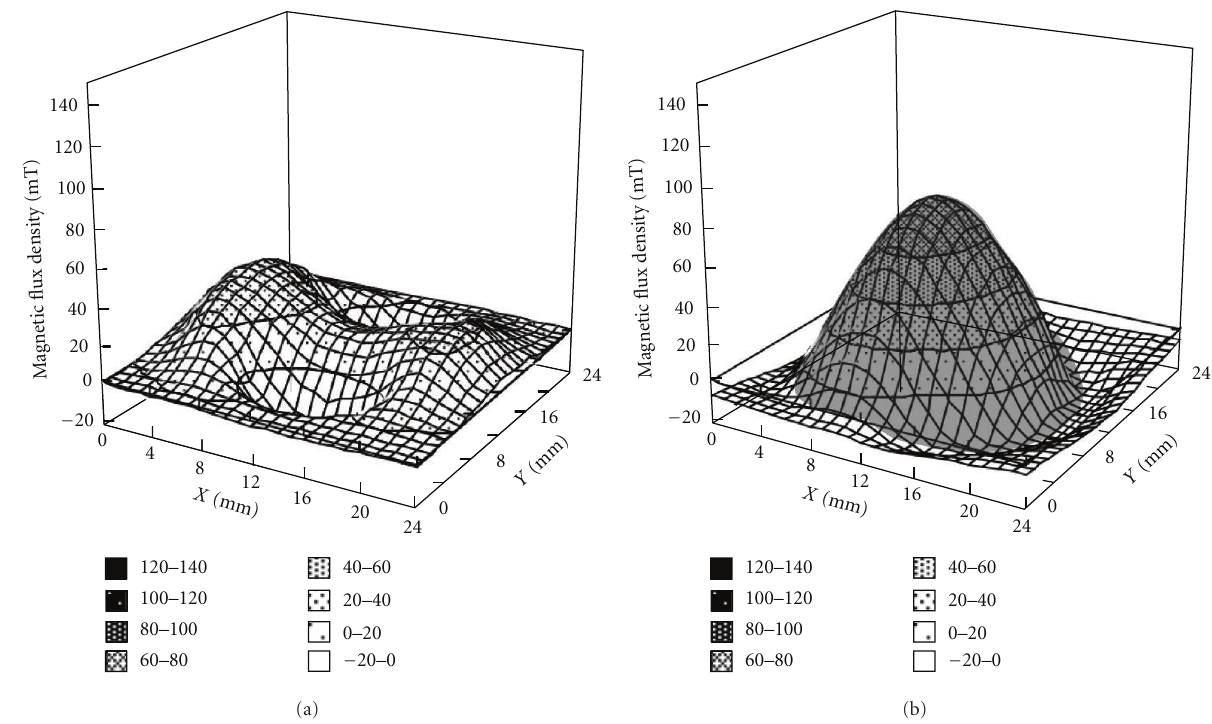
Figure 17: Distribution of magnetic flux density after the magnetization in the opposite direction.